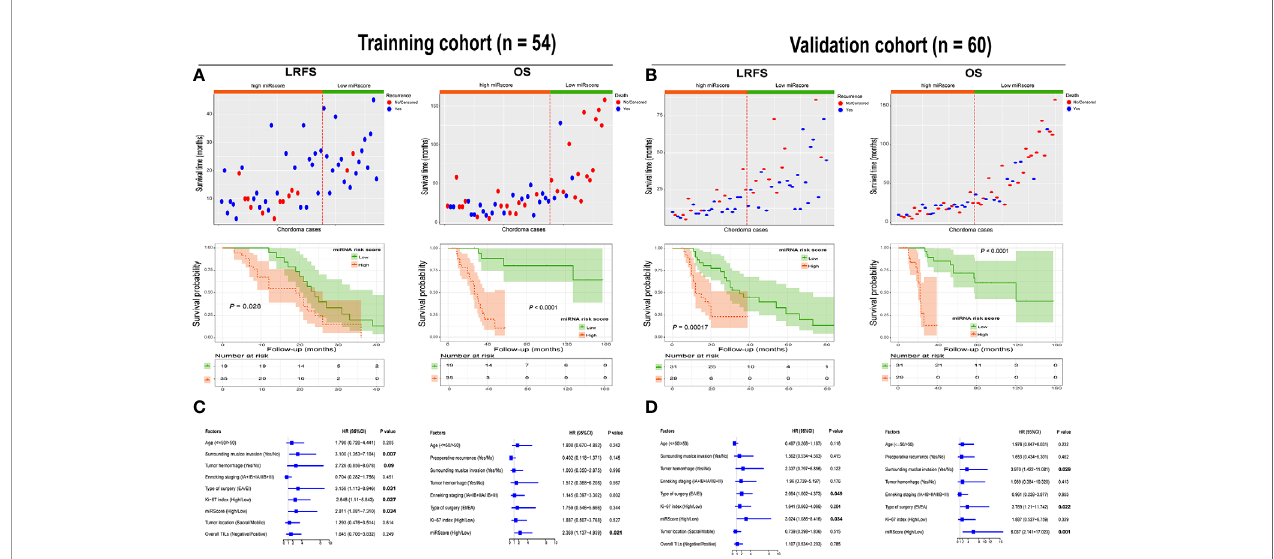
FIGURE 5 | (A) Distribution of recurrence and survival status in chordoma patients strati fi ed by the miRscore data in the training cohort (top). Red dotted line represents the miRscore cutoff dividing patients into high and low groups. Kaplan-Meier curve of LRFS and OS according to low or high miRscore group (middle). (B) Distribution of recurrence and survival status in chordoma patients strati fi ed by the miRscore data in the training cohort (top). Red dotted line represents the miRscore cutoff dividing patients into high and low groups. Kaplan-Meier curve of LRFS and OS according to low or high miRscore group (middle). (C) Multivariate Cox regression model for LRFS and OS of spinal chordoma patients in the training cohort. The boxes indicate the hazard ratio, and the horizontal lines represent 95% con fi dence intervals. (D) Multivariate Cox regression model for LRFS and OS of spinal chordoma patients in the validation cohort. miRscore, microRNA risk score; LRFS, local recurrence-free survival; OS, overall survival.